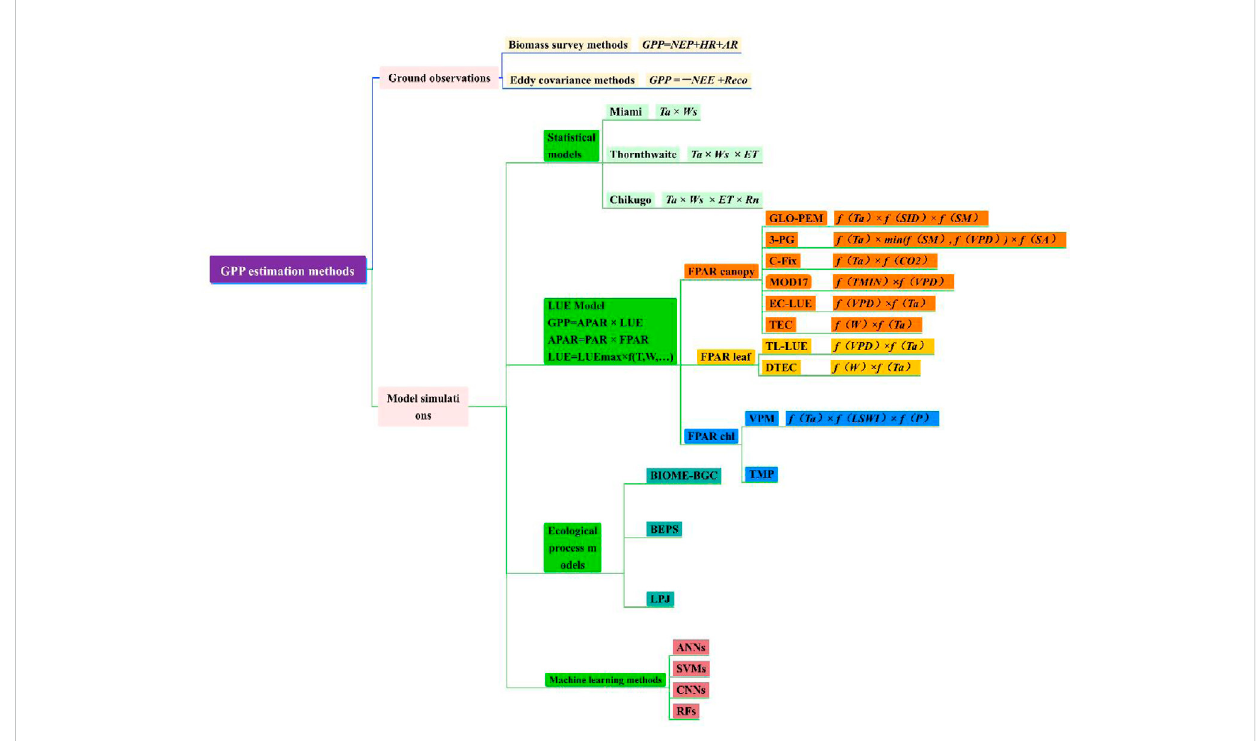
FIGURE 4 Summary of estimation methods of